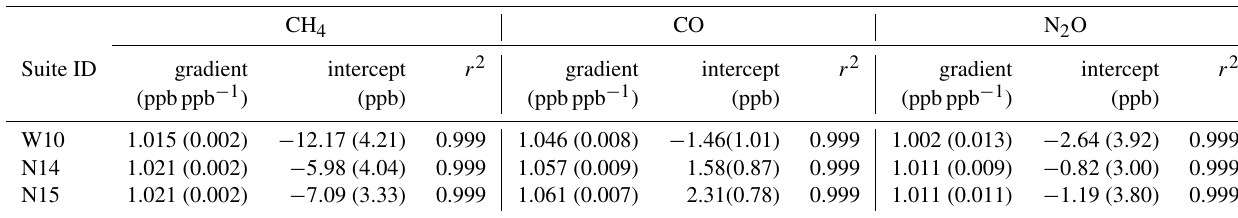
Figure 8. (a) CH 4 7-day running mean calibration scale factor ( A sf ). Black data points are the drift-corrected calibration scale factors. Uncorrected calibration scale factors are shown as grey data points. The vertical dashed red line indicates the WS replacement and (b) , CH 4 scale factor uncertainty. Panels (c) and (d) show the same as (a) and (b) but for CO. Panels (e) and (f) show the same as (a) and (b) but for N 2 O. Table 4. The Complete-IRF gradient and intercept coefficients for each species calculated from three suite measurements sets (1 σ uncertainty in brackets). W10 is the WCC-EMPA travelling standard suite measured in 2010. N14 and N15 are the measurements of the Aniwaniwa suite in 2014 and 2015 respectively. The coefficient of determination ( r 2 ) of each fit is